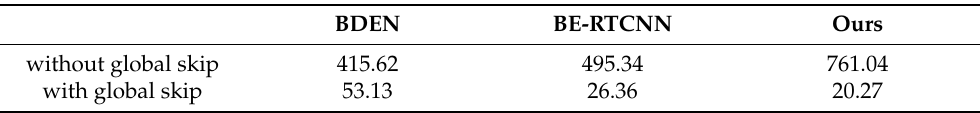
Figure 10. CDF of the number of out-of-bounds pixels for three network structures with and without global skip connections. * refers to our implemented version. Table 4. Average numbers of out-of-bounds pixels of three network structures on 1909 randomly selected images with and without global skip